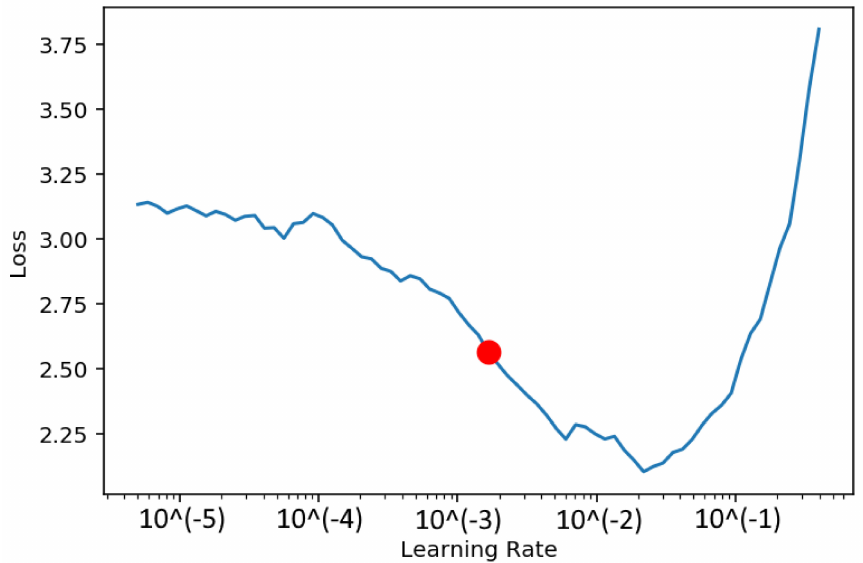
Figure 3. The optimal learning rate of the MobileNet-V2 model is 1.66 × 10 − 3 . We are using this optimum rate for training our model.